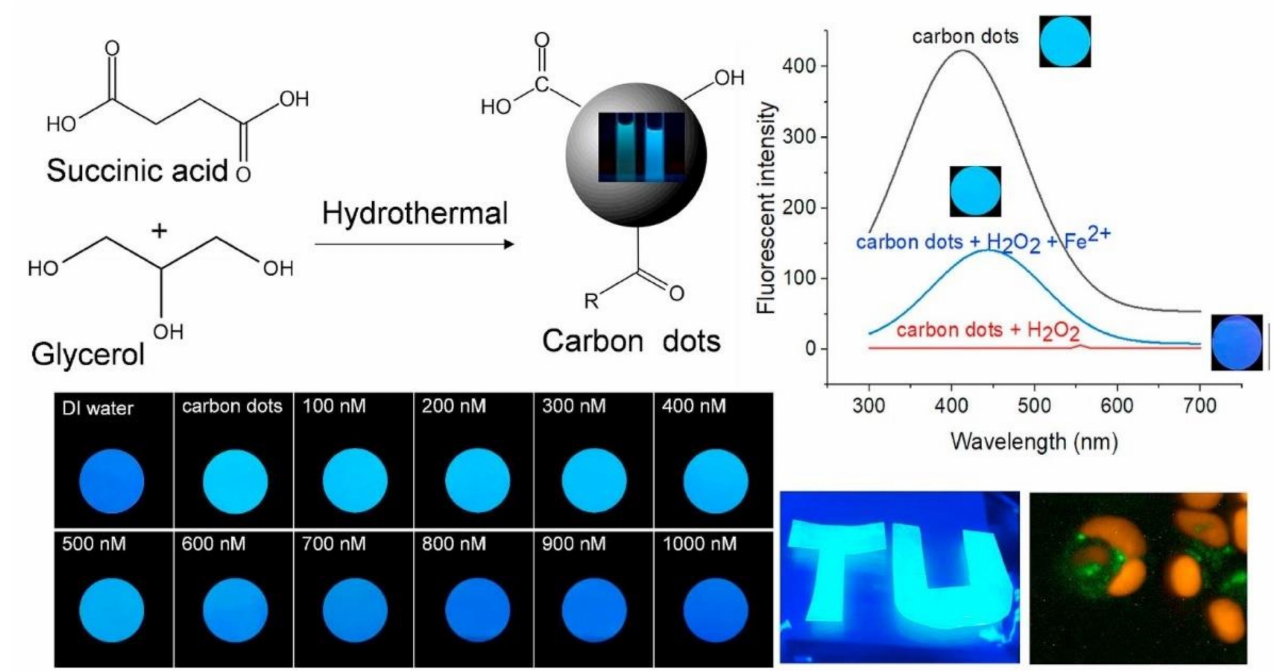
Figure 2. Representation of CQD hydrothermal synthesis, CQDs under UV illumination and practical application. Reprinted from ref. [33], with permission from